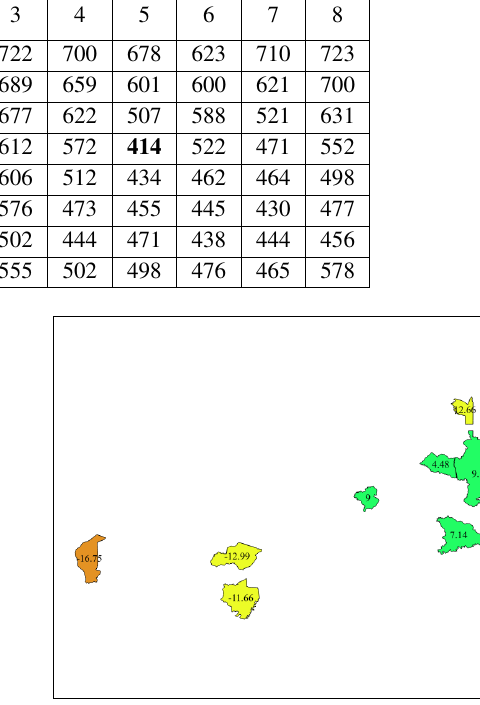
Figure 3. Percent deviation between actual and predicted yield at municipality